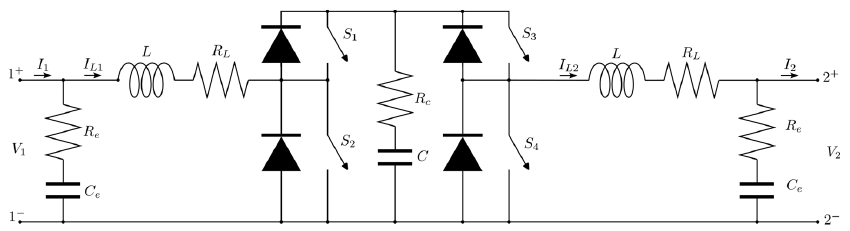
Figure 1. Schematics of the Split-pi converter. Table 1. Operating modes of the Split-pi converter.